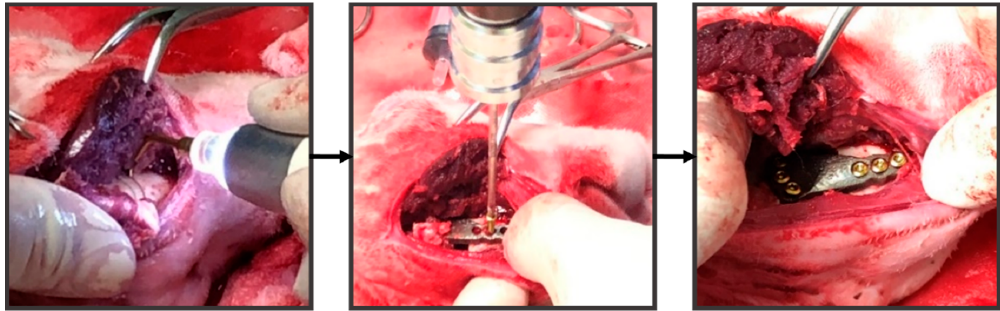
Figure 3. Animal experiments to place a specific reconstruction implant in the right corresponding region of the rabbit mandible.